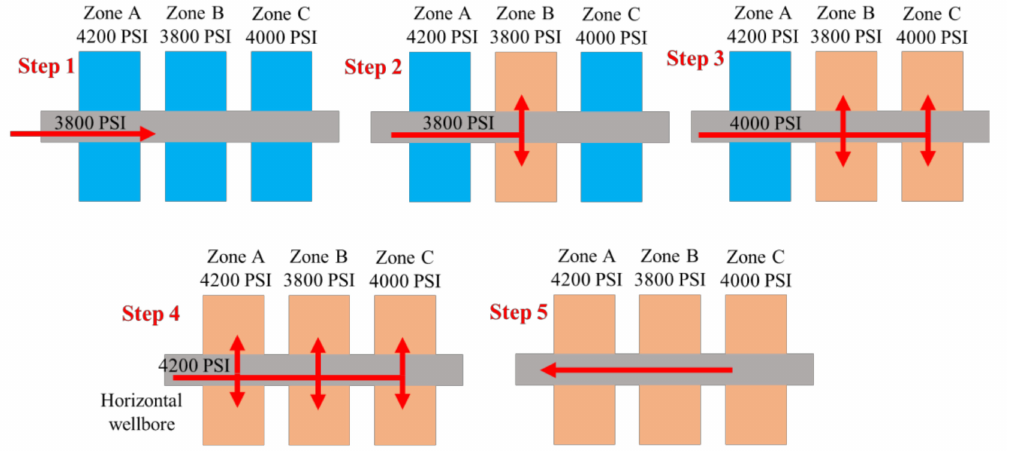
Figure 1. Mechanism of LEF during horizontal well